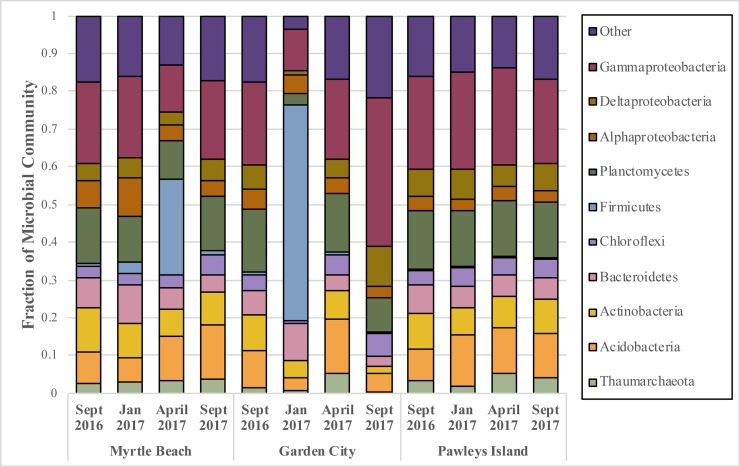
Seasonal phylum composition for all sand samples pooled together from each sampling date.Sampling dates include September 2016, January 2017, April 2017, and September 2017. The Proteobacteria phylum has been divided into classes to display members making up ≥ 1% of the community.